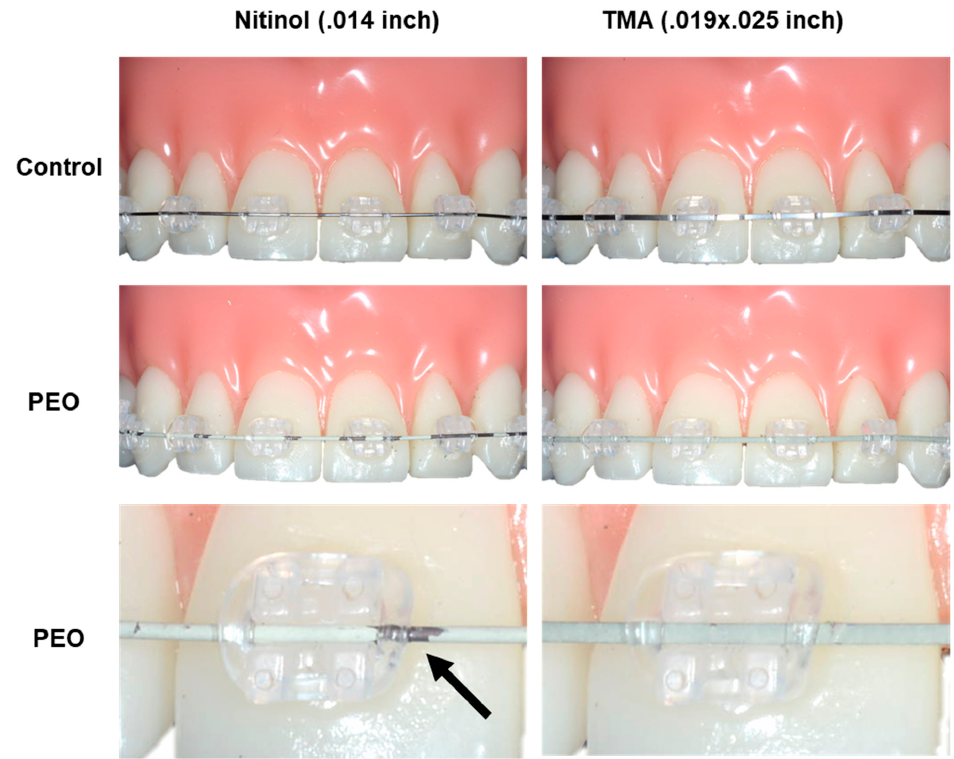
Figure 5. PEO-coated NiTi and β -Ti archwires in an orthodontic phantom model. Non-coated archwires are shown for comparison (upper panels). Multiple insertion of the NiTi archwires results in loss (black arrow) of the PEO-coating (middle and lower panels). In contrast, The PEO-coating on the β -Ti wire is stable also after repeated